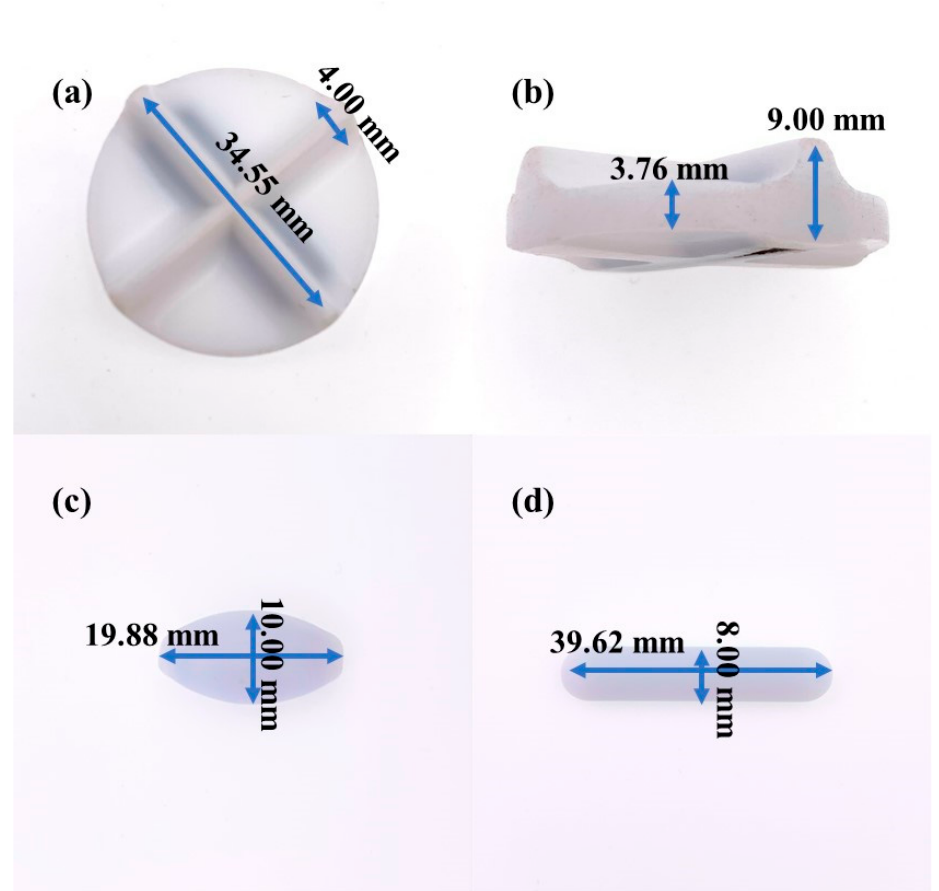
Figure 2. Images of the different stirrers: ( a ) plan view of stirrer 1; ( b ) elevation view of stirrer 1; ( c ) stirrer 2; ( d ) stirrer 3.